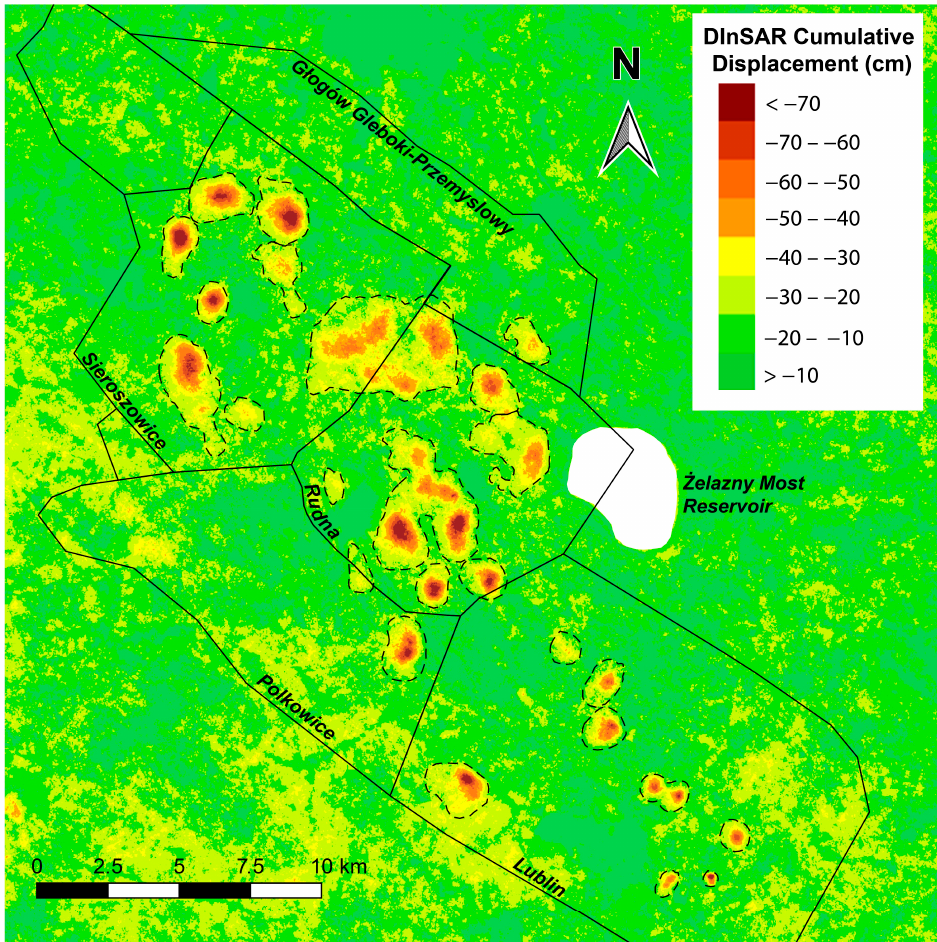
Figure 7. DInSAR cumulative displacement at the LGCD mines, from October 2014 to April 2019; black lines represent LGCD mine district borders; dashed black lines represent the perimeters of the areas subject to a subsidence >30 cm.